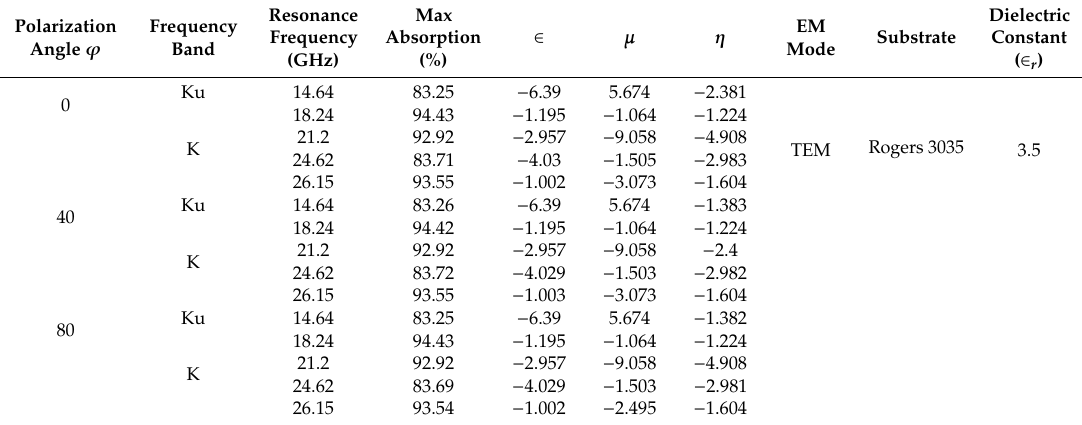
Table 4. Absorption at di ff erent polarizing angles in TEM mode for RT 3035